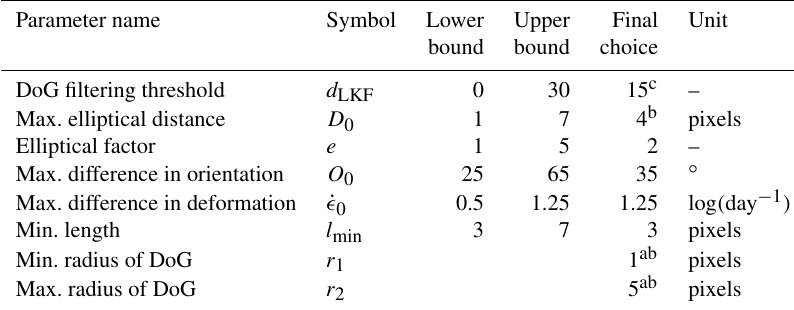
Table 1. List of parameters used in the LKF detection algorithm. For each parameter the lower and upper bounds of the optimization are given along with the final choice of the parameter value.